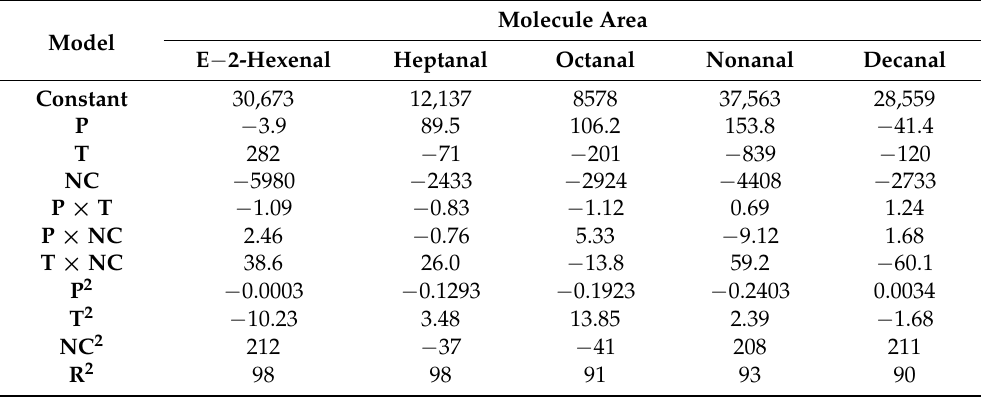
Table 5. RSM statistical analyses of MFA treatment data.